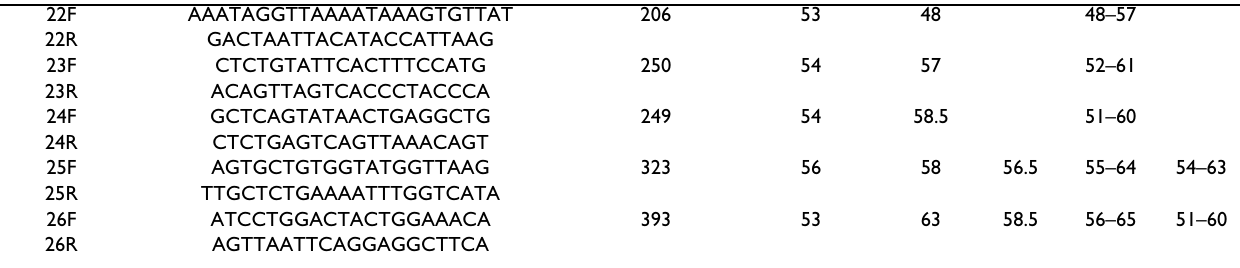
Table 1: Primer pairs and PCR conditions for DHPLC analysis.